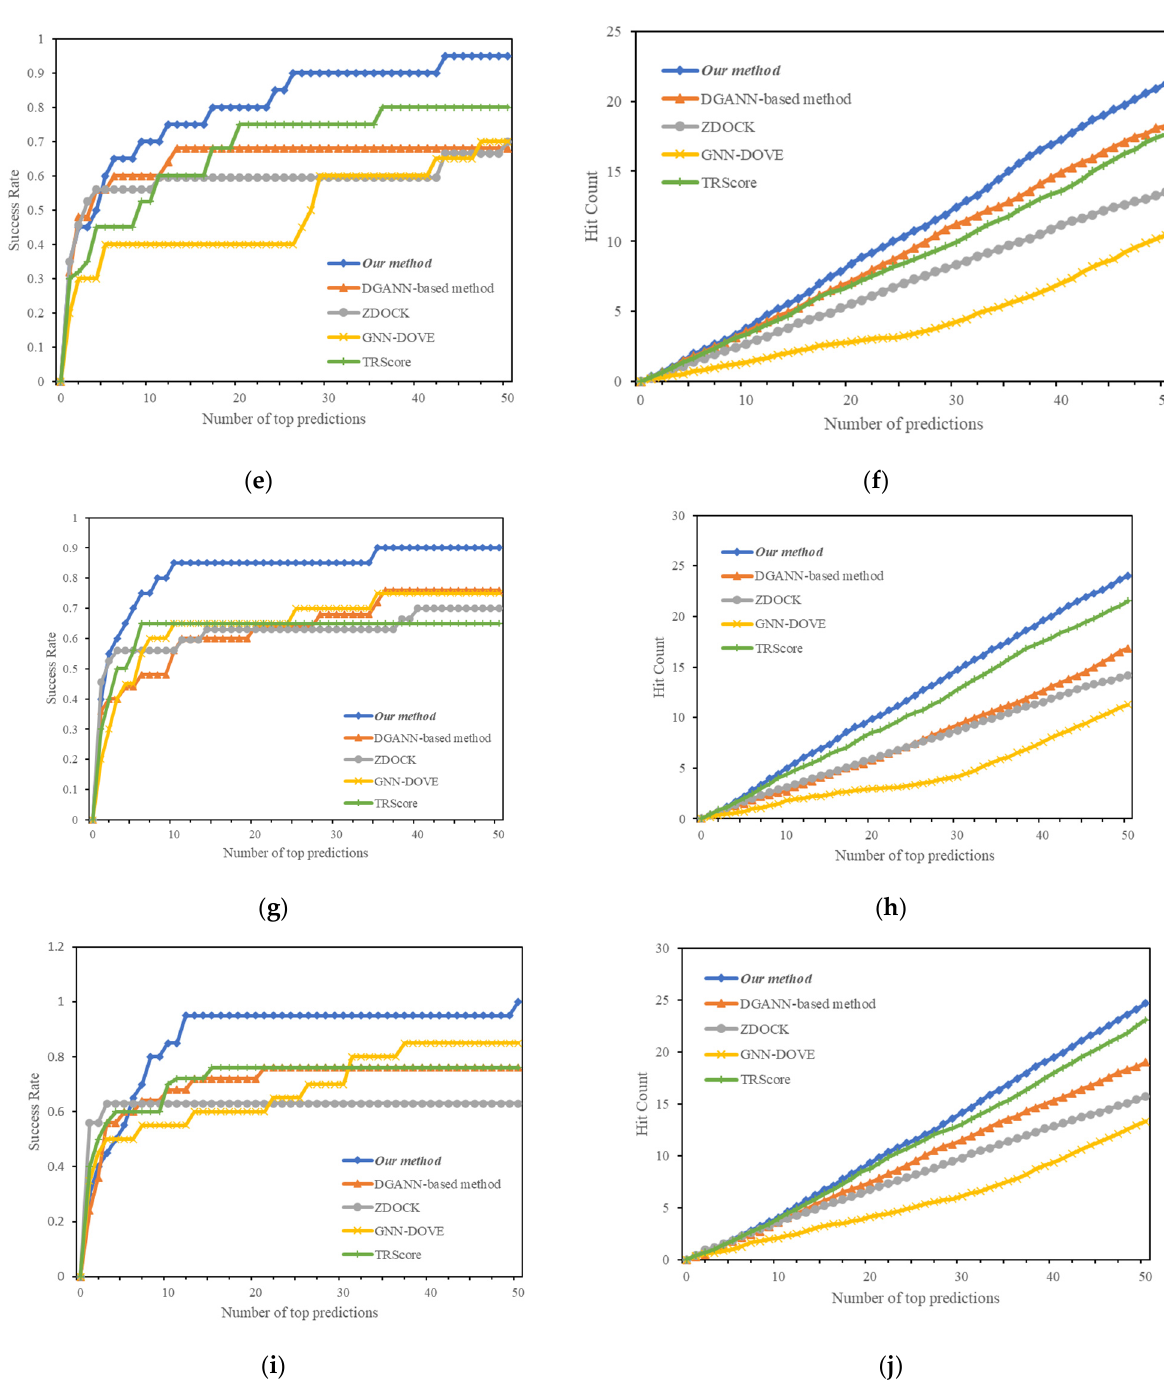
Figure 5. The success rate and hit count are shown for each fold in the cross-validation on the ZDOCK benchmark 4.0. ( a , b ) The success rate and hit count of the fold 1 test set. ( c , d ) The success rate and hit count of the fold 2 test set. ( e , f ) The success rate and hit count of the fold 3 test set. ( g , h ) The success rate and hit count of the fold 4 test set. ( i , j ) The success rate and hit count of the fold 5 test set.